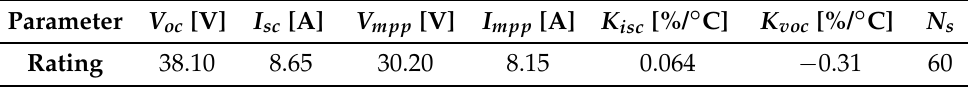
Table 2. Specification of PV Module at Standard Test Condition [30]